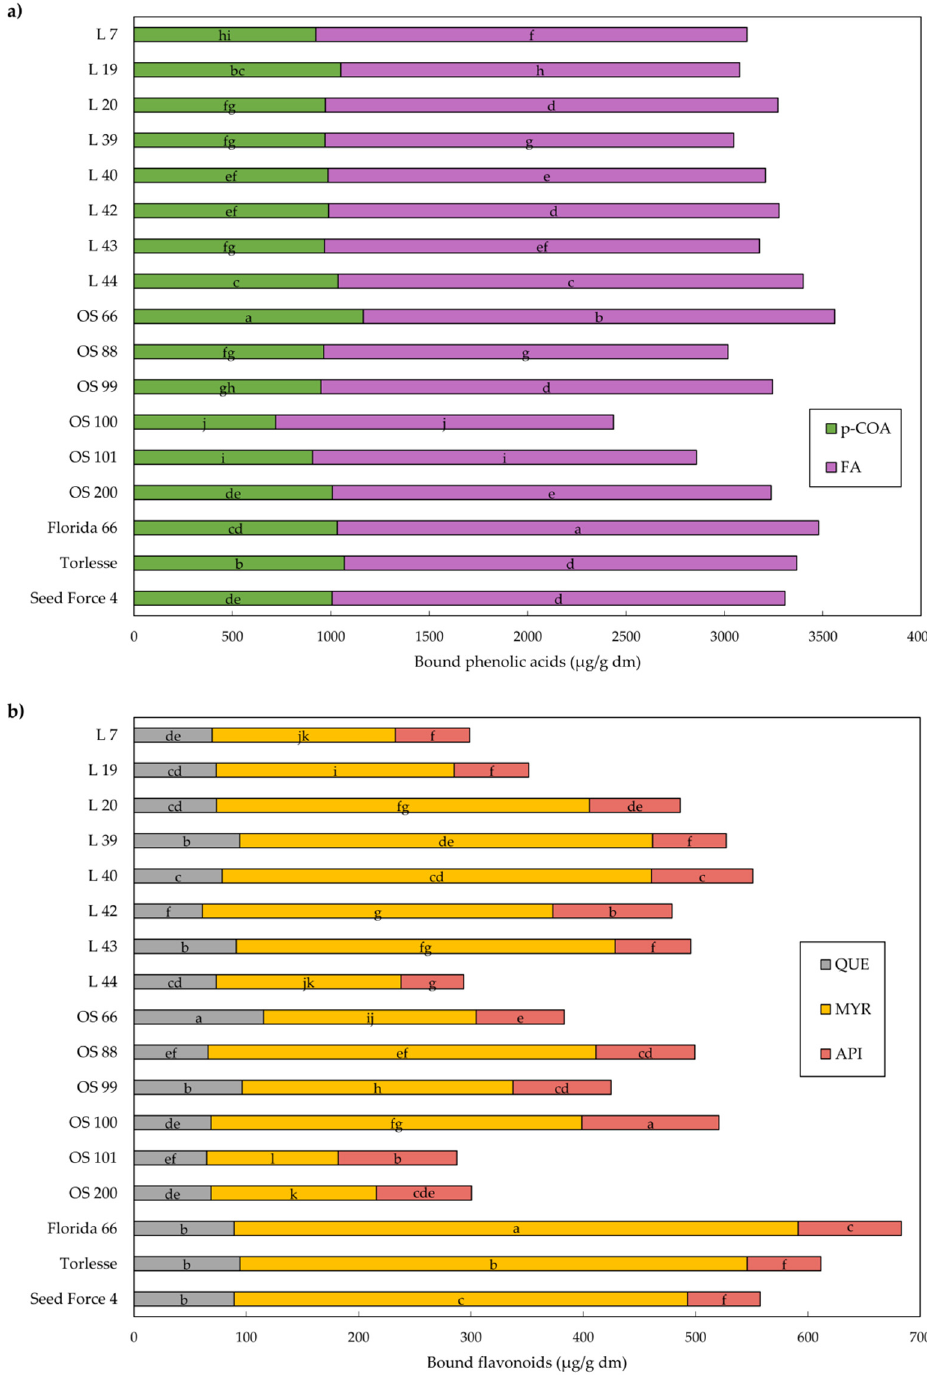
Figure 3. Mean values of bound phenolic acids ( a ) and flavonoids ( b ) in alfalfa. Different letters indicate significant difference among accessions at p < 0.05 according to the LSD test. p-COA—p-coumaric acid; FA—ferulic acid; QUE—quercetin; MYR—myricetin; API—apigenin.